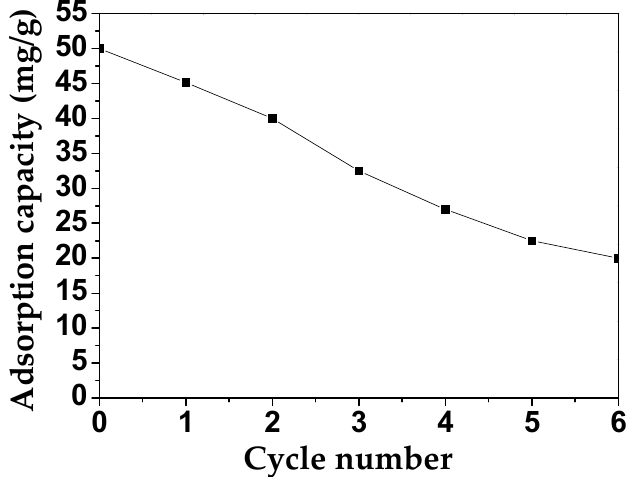
Figure 10. Determination of the recyclability of MAFC based on the adsorption rate of emulsified oil.